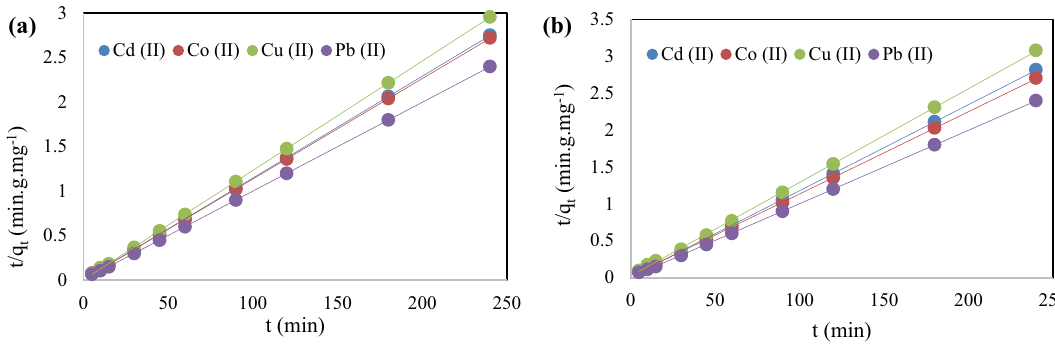
Figure 8. Pseudo-second order kinetic modeling of Cd (II), Co (II), Cu (II), and Pb (II) metal ions using ( a ) TPP-CMN and ( b ) V-CMN nano-sorbents.